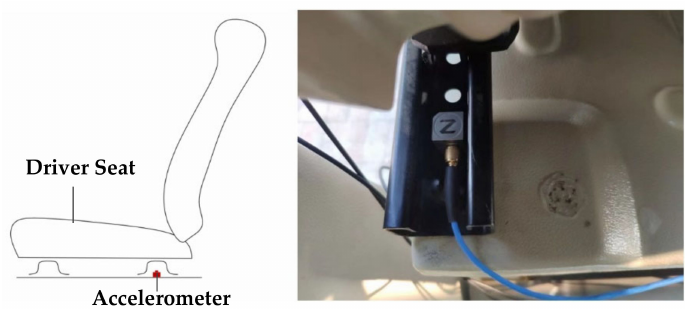
Figure 3. The accelerometer mounted at the driver seat rail.